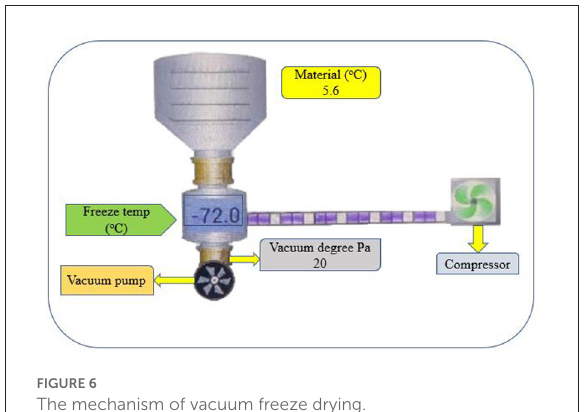
FIGURE6 The mechanism of vacuum freeze